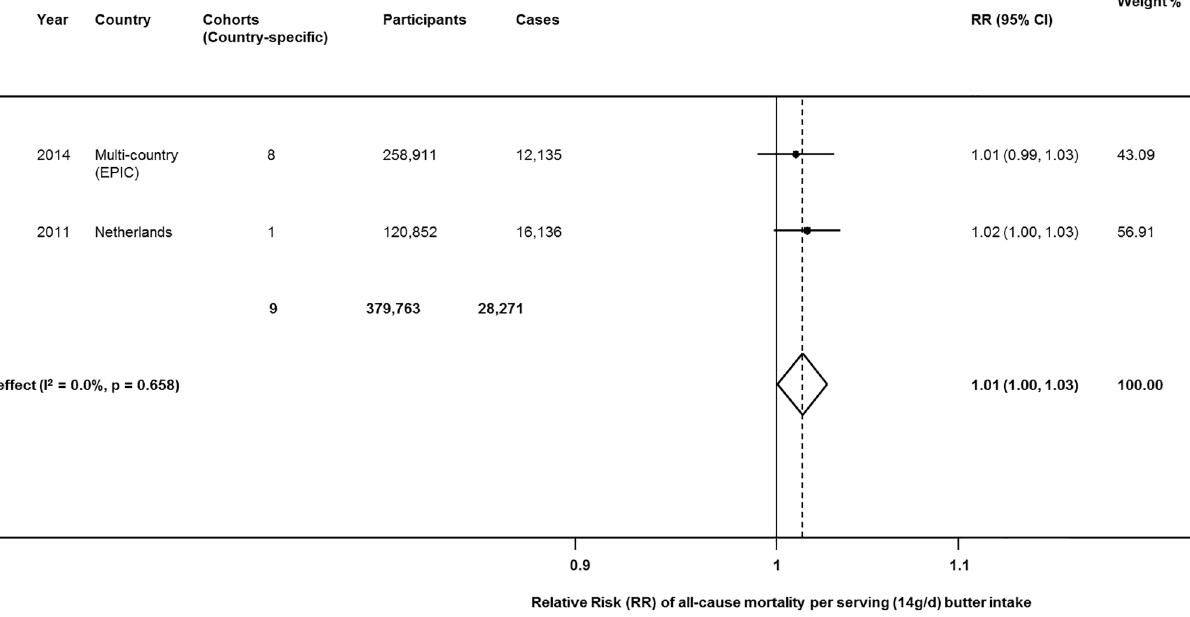
PLOS ONE | DOI:10.1371/journal.pone.0158118 June 29,